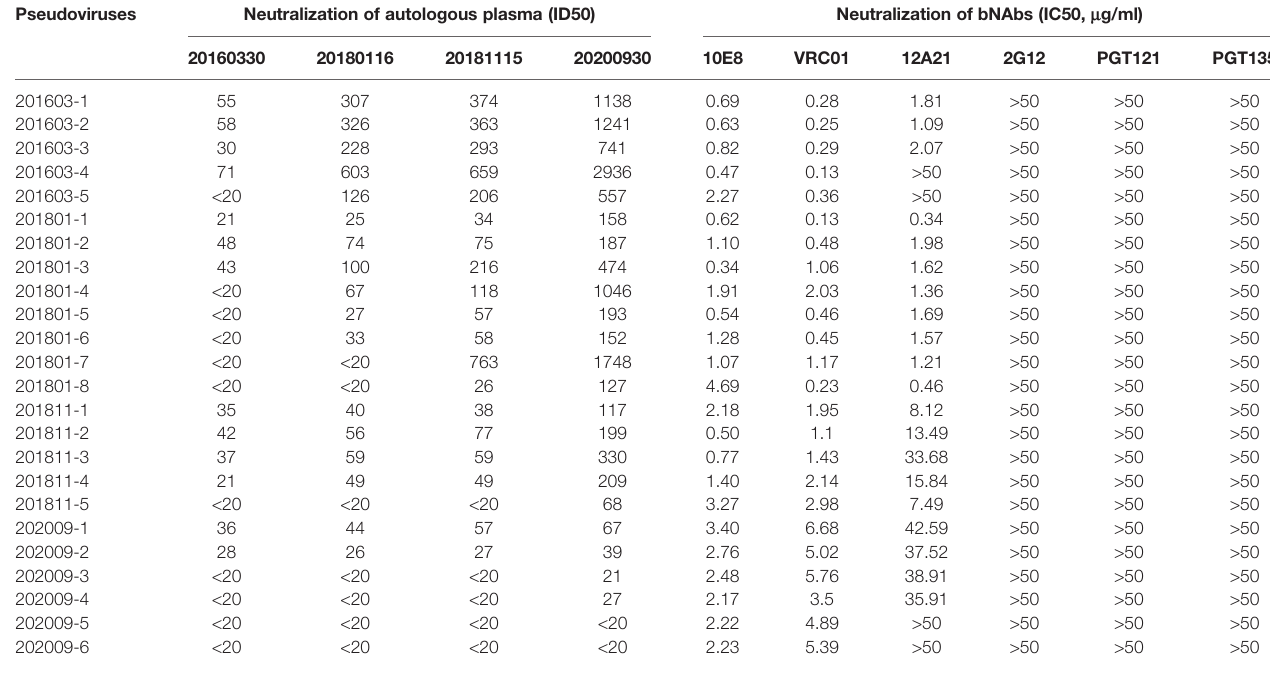
TABLE 1 | Neutralization sensitivity of pseudoviruses to autologous plasma and bNAbs.